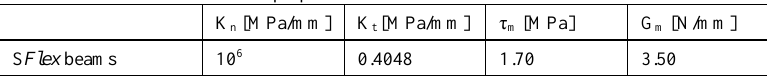
Table 1: Mechanical properties used in the simulation of the